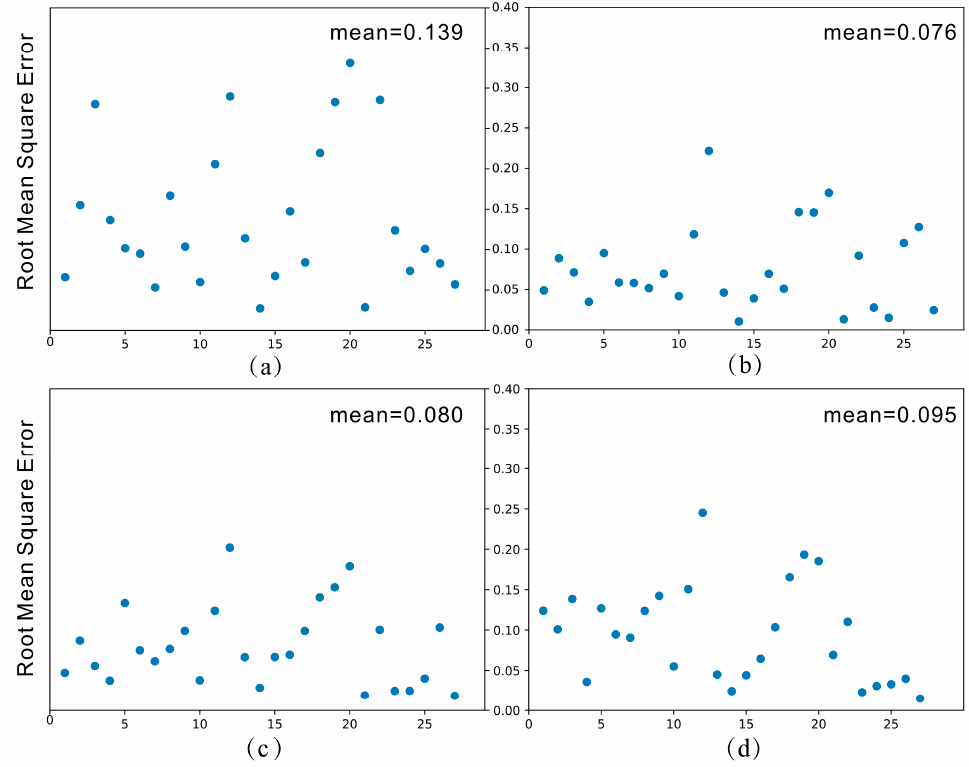
Figure 7. RMSE of each interpolation result with different search scopes: ( a ) 10,000 m; ( b ) 15,000 m; ( c ) 20,000 m; and ( d ) 30,000 m.